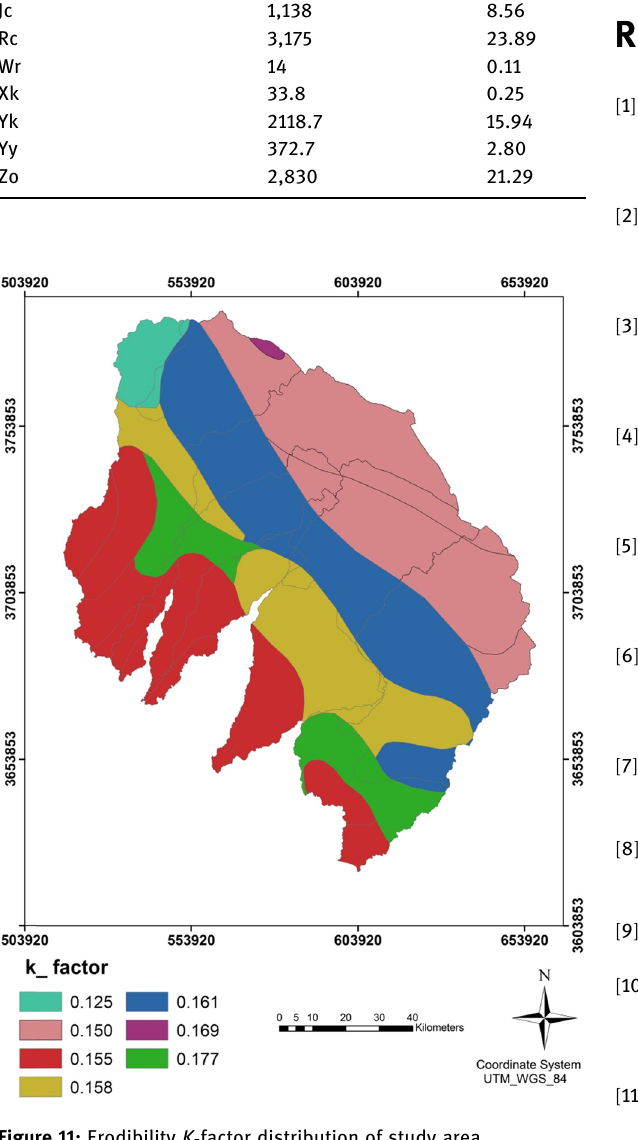
Figure 11: Erodibility K - factor distribution of study